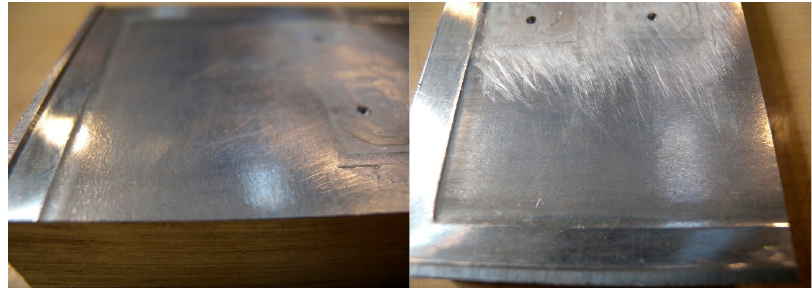
Figure 15. Example of damaged surface due to the use of aggressive parameters.